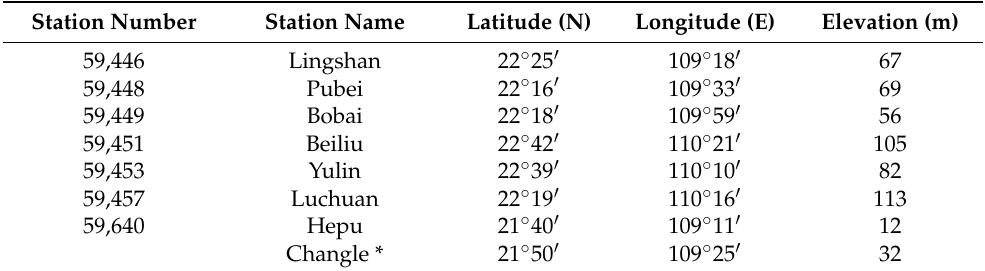
Table 1. List of the eight stations over the Nanliu River basin, including the station number, station name, latitude, longitude, and elevation (a.s.l.). * Changle is a hydrological station with precipitation